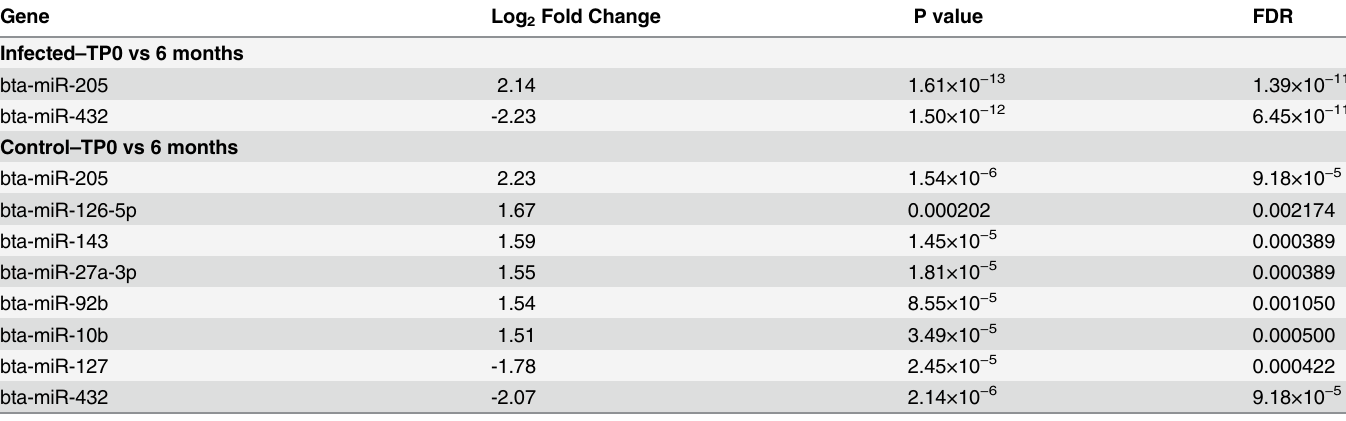
Table 3. Differentially expressed miRNA identified by comparing time-point 0 to time-point 6 months within each group (MAP-infected versus controls). Gene Log 2 Fold